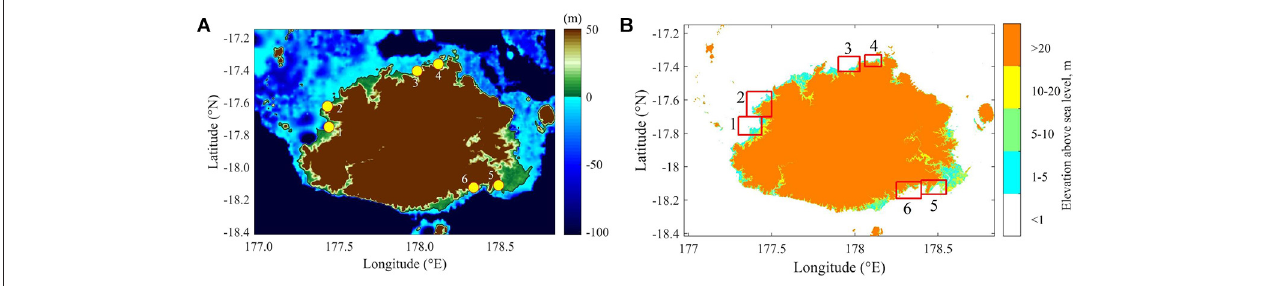
FIGURE 3 | Computational domain, bathymetry, and topography with the selected low-lying locations [contour indicates elevation (m), (A) ] and the map indicating altitude changes in Viti Levu (B) .